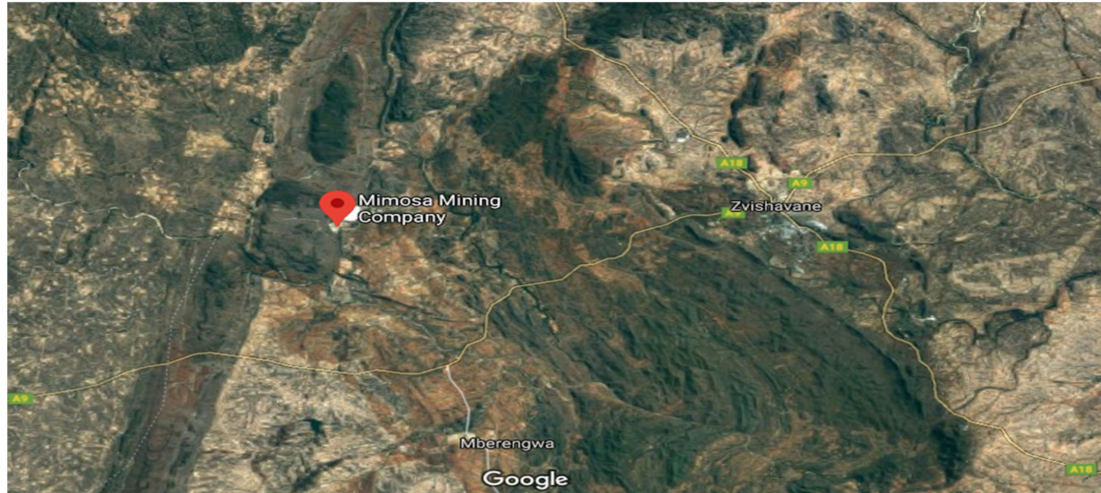
Figure 1. Satellite location for Mimosa Mine (Source: Google